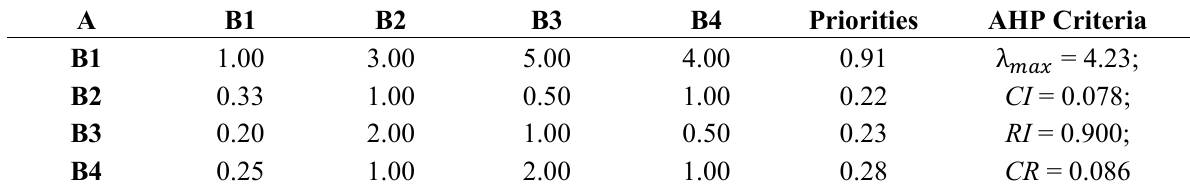
Table 2 . Judgment matrix of the objective hierarchy and the criterion hierarchy.